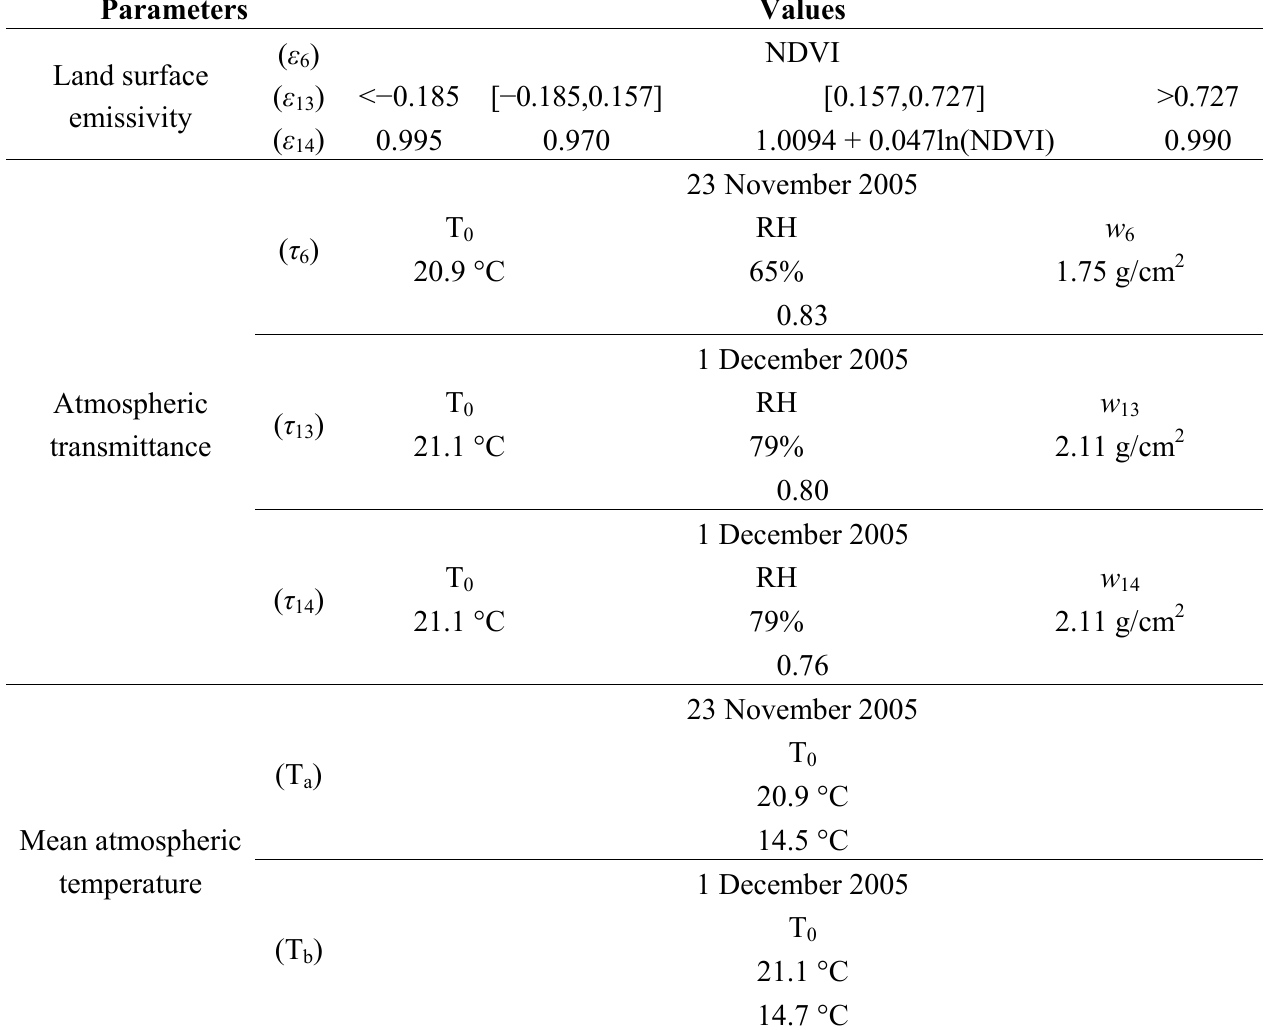
Table 6. All parameters used for retrieving LST for Hong